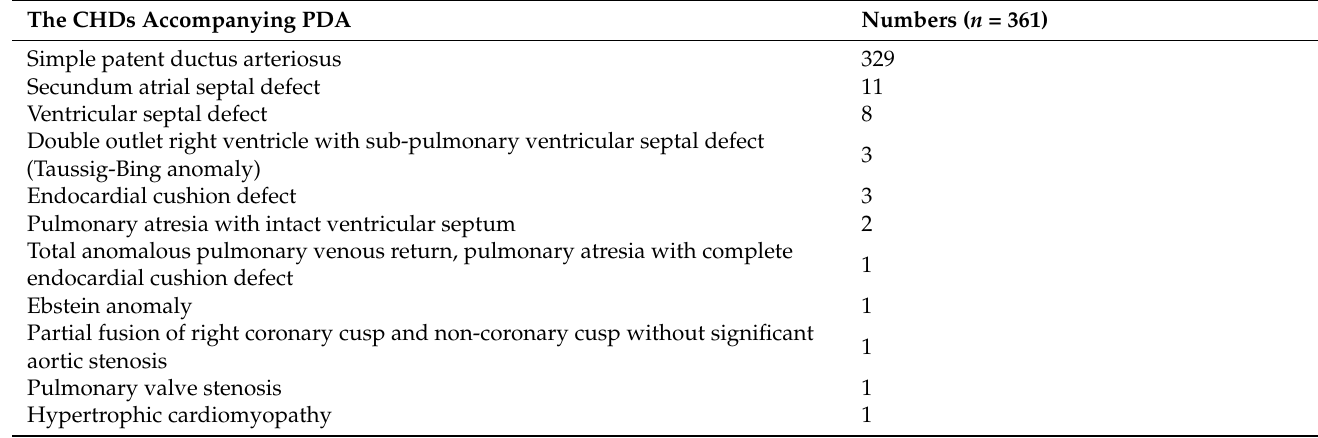
Table 5. Various comorbidities of congenital heart disease (CHD) accompanying PDA occlusion using NOC.